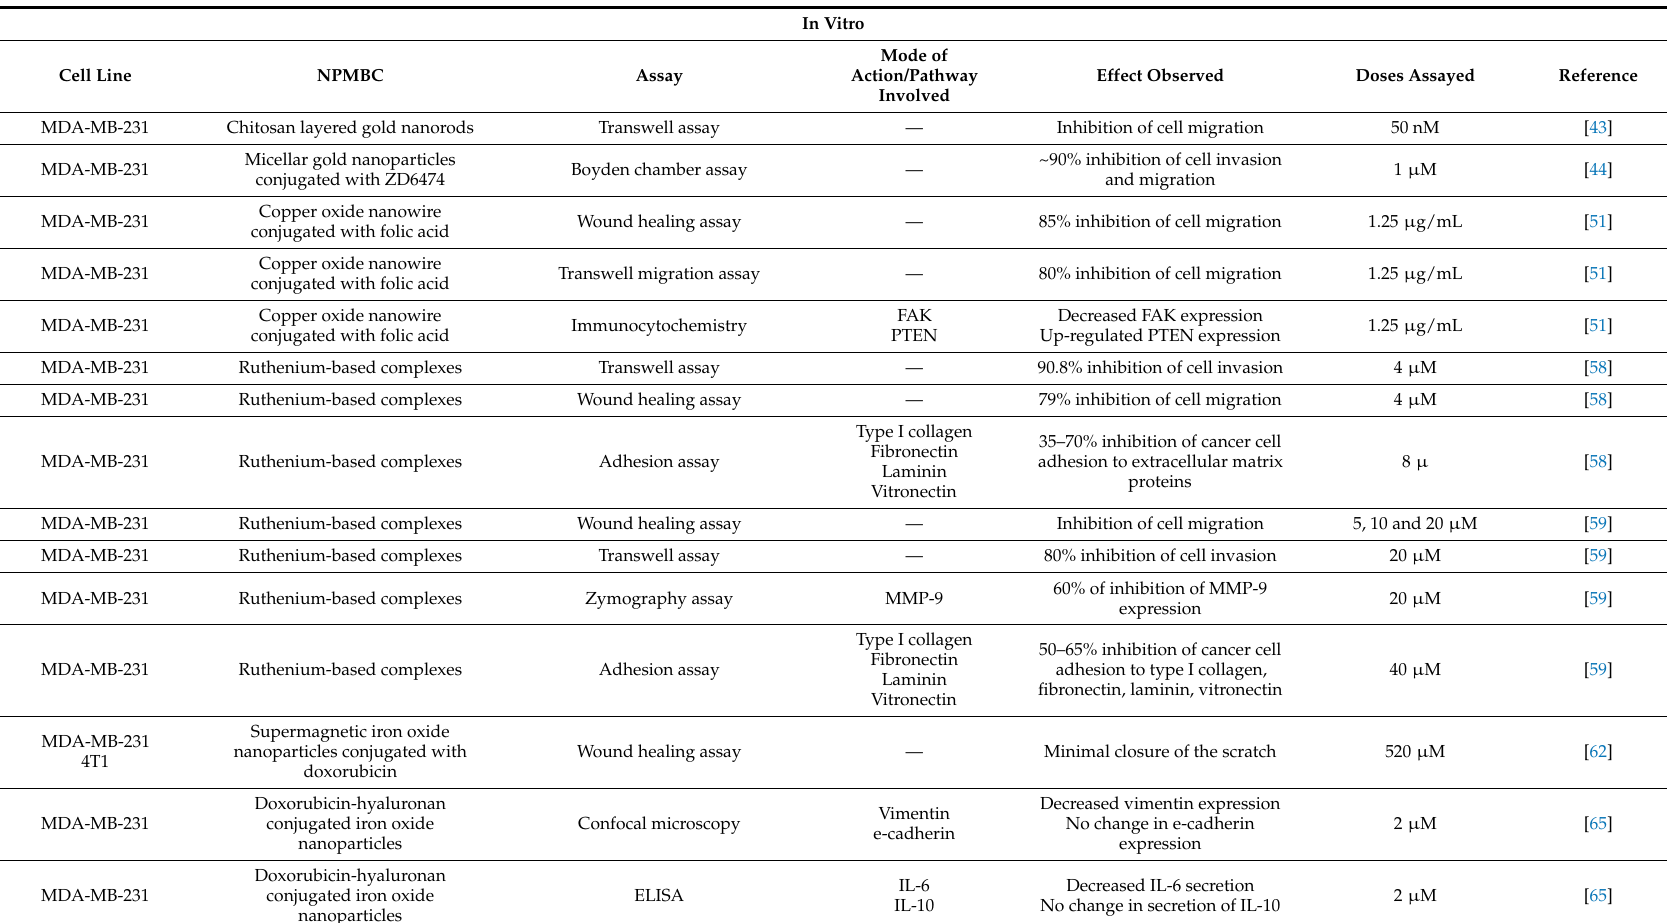
Table 5. Non-platinum metal based complexes (NPMBC) inhibit the in vitro and in vivo growth of triple-negative breast cancer (TNBC) cells by inhibiting migration, invasion and/or